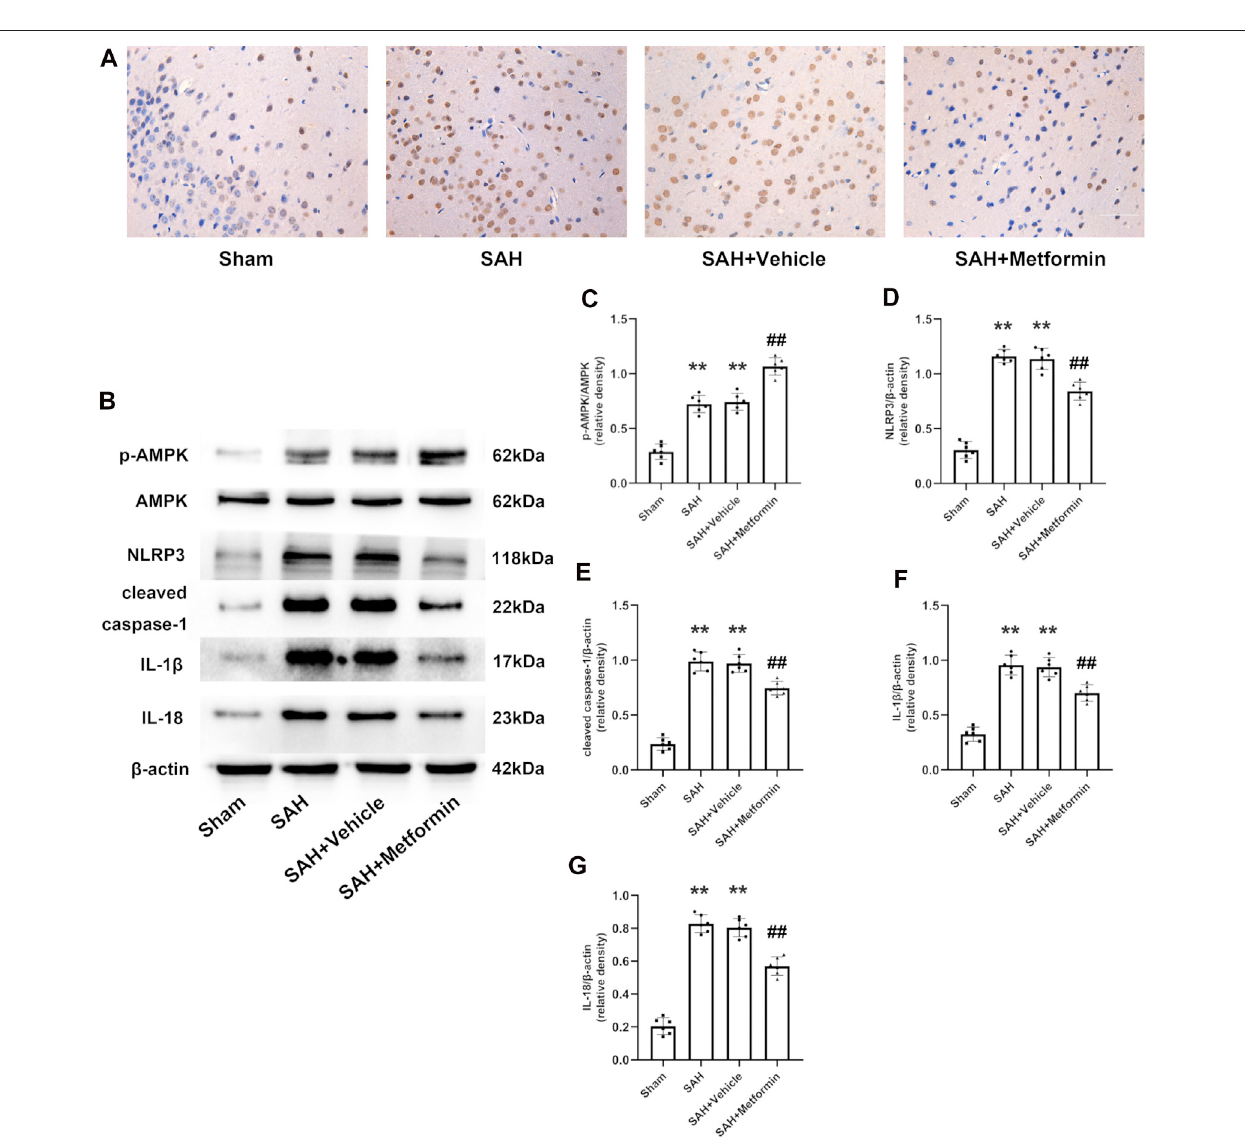
FIGURE6| MetforminsuppressesNLRP3-associatedin fl ammatoryresponse. (A) Representativeimagesofimmunohistochemicalstaining(Magni fi cation=×400, scalebar=50um, n =5pergroup). (B) Representativewesternblotimages. (C – G) Quantitativeanalysisofwesternblot. N =6foreachgroup.Dataareshownasmean± SD. ** p < 0.01 vs. sham group. ## p < 0.01 vs. SAH + Vehicle (normal saline)